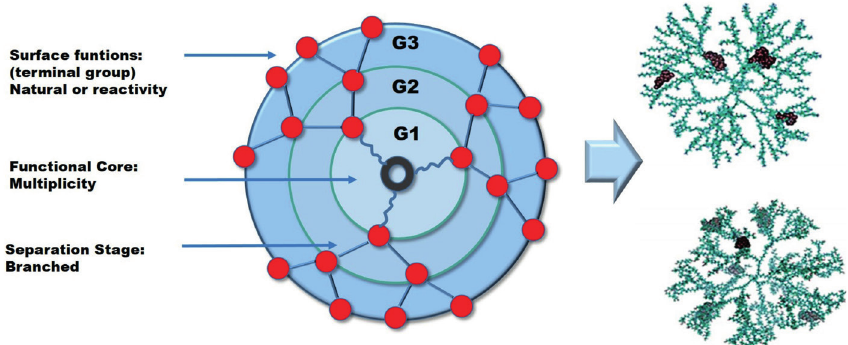
Figure 1 - Architectural components of